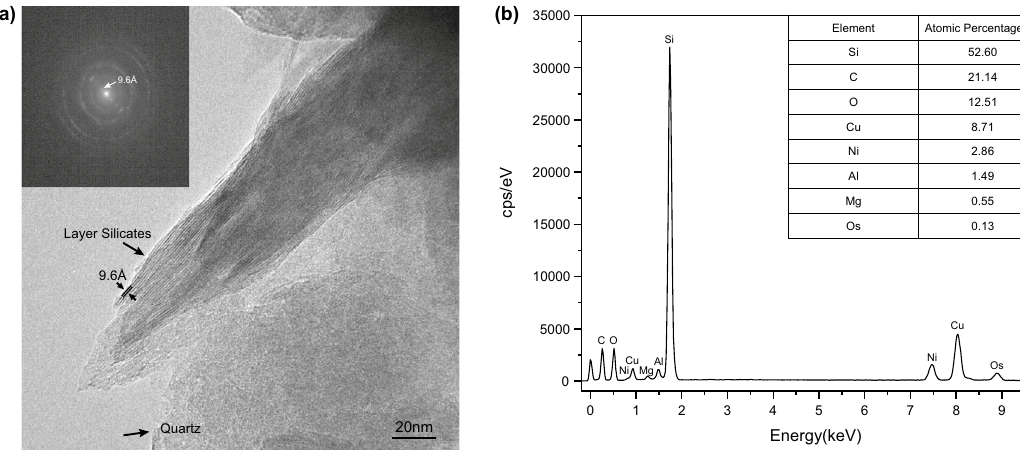
Figure 6. Results of TEM observations. ( a ) In chrysoprase, nanometre-size layer silicates with interlayer distances of 9.6 Å are found frequently in the quartz crystals and at their boundaries. The diffuse and weak ring-shaped selected area electron diffraction (SAED) patterns of layer silicates, in which strong reflections 9.6 Å are observed, are shown in the upper left corner of the figure. ( b ) The result of energy-dispersive spectrometer